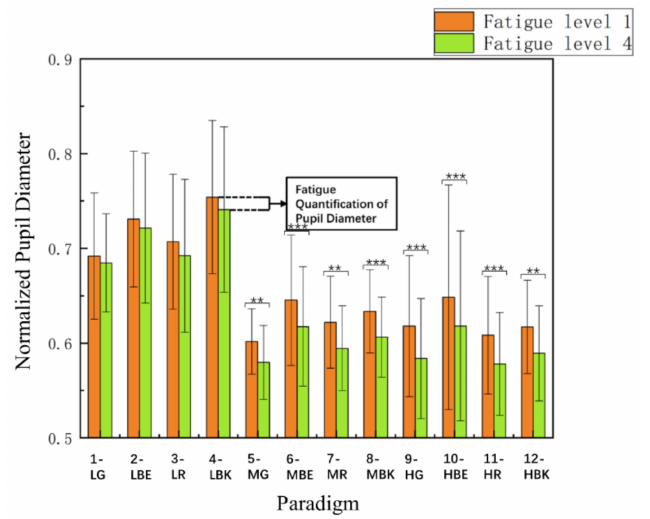
Figure 8. Comparison of the mean values and SD of normalized pupil diameter index between fatigue level 1 and fatigue level 4 for 12 stimulus paradigms over 15 subjects. Statistics were assessed by one-way repeated-measures ANOVA. *** p < 0.001; ** p < 0.01. In the in-depth analysis, 12 stimulus paradigms were divided into three groups by the same brightness and different colors as before (low brightness (paradigm 1, 2, 3, 4), medium brightness (paradigm 5, 6, 7, 8), high brightness (paradigm 9, 10, 11, 12)). The low bright- ness group [F (1.355, 18.974) = 0.148, p = 0.780] showed no significant differences. Similarly, there was no significant difference in the medium brightness group [F (1.163, 16.276) =